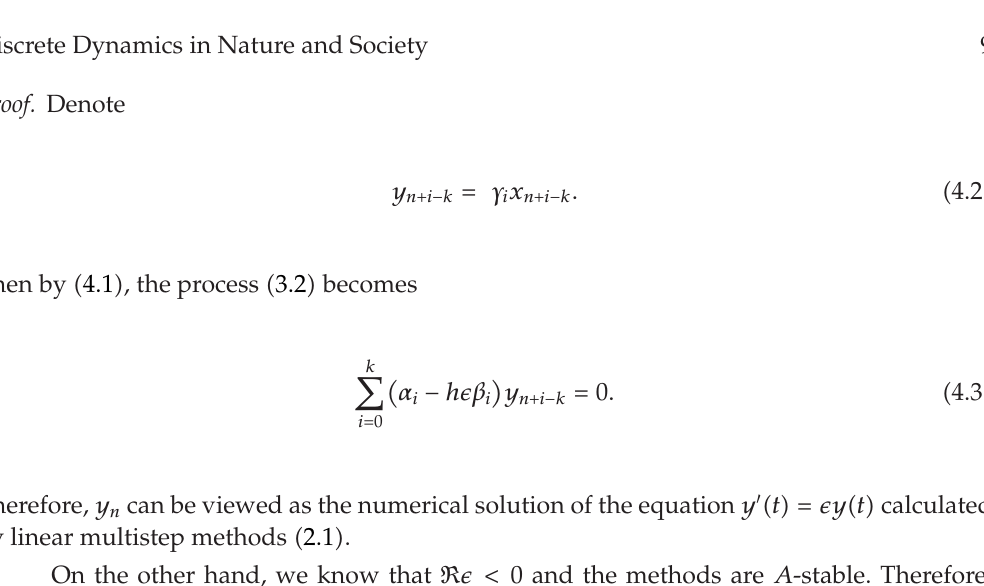
Figure 1. Figure 1 indicates that the numerical solutions are not asymptotically stable. Hence, we will give another improved linear multistep method in the next